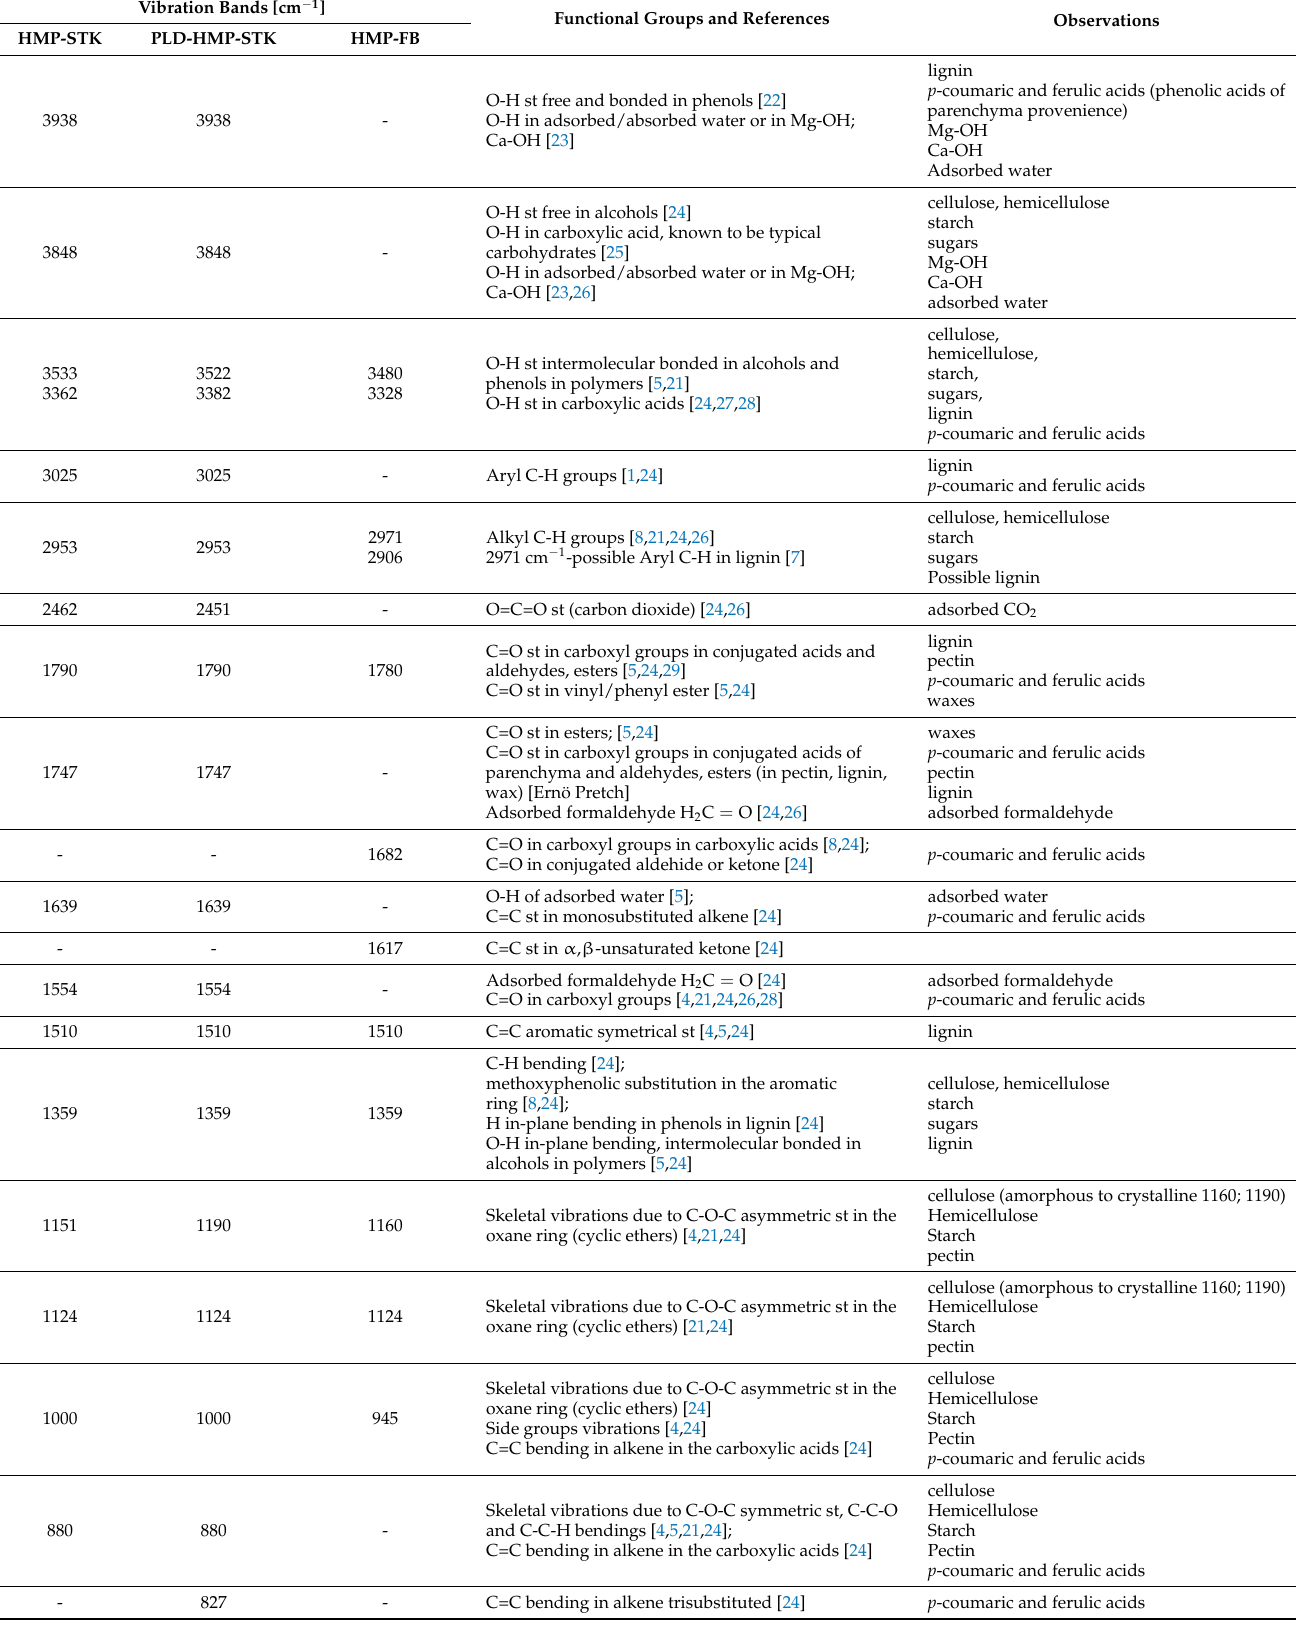
Table 1. Functional groups corresponding to the vibration bands in the spectra of Figure